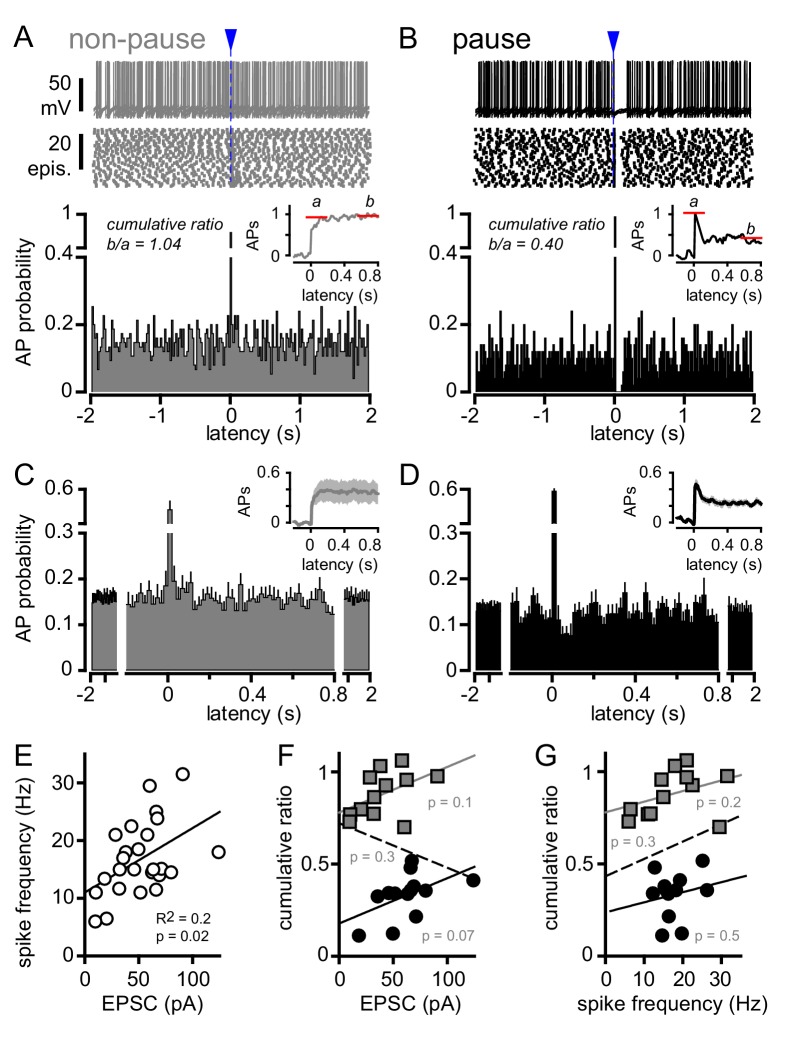
CF stimulation can suppress GoC firing.(A, top) Example traces (10 traces overlaid) and (middle) raster plot from a GoC that increases spiking in response to CF stimulation (blue arrow and dotted line) and immediately returns to baseline firing rate. (A, bottom) PSH of GoC spike probability (20 ms bin) with CF stimulation at time = 0 s. Inset shows the PSH integral to yield the cumulative spike probability (see text). Red lines illustrate the ratio of the steady state (b) to peak number of spikes (a) added with each stimulus to define a cumulative ratio (b/a). (B, top) Example traces (10 traces overlaid) and (middle) raster plot from a GoC that displays a suppression of GoC spiking following CF stimulation (arrow). (B, bottom) PSH of GoC spike probability (20 ms bin) with CF stimulation at time = 0 s. Inset shows the PSH integral to yield the cumulative spike probability with red lines illustrating the low cumulative ratio indicative of spike suppression. (C and D) Average PSHs for non-pausing (grey; cumulative ratio >0.65; n = 12 of 25) and pausing (black; cumulative ratio <0.65; n = 13 of 25) GoCs. Insets are the average cumulative spike probability for the non-pausing and pausing GoCs. (E) Summary plot showing that the average spike frequency is correlated with the EPSC amplitude (linear regression, n = 25 cells). (F) No correlation between the cumulative ratio and EPSC amplitude using all (dotted line), only non-pausing (grey squares and line), or pausing cells (filled circles and solid line). (G) No correlation between the cumulative ratio and average spike frequency using all (dotted line), only non-pause (grey squares and line), or pause cells tested (filled circles and solid line).